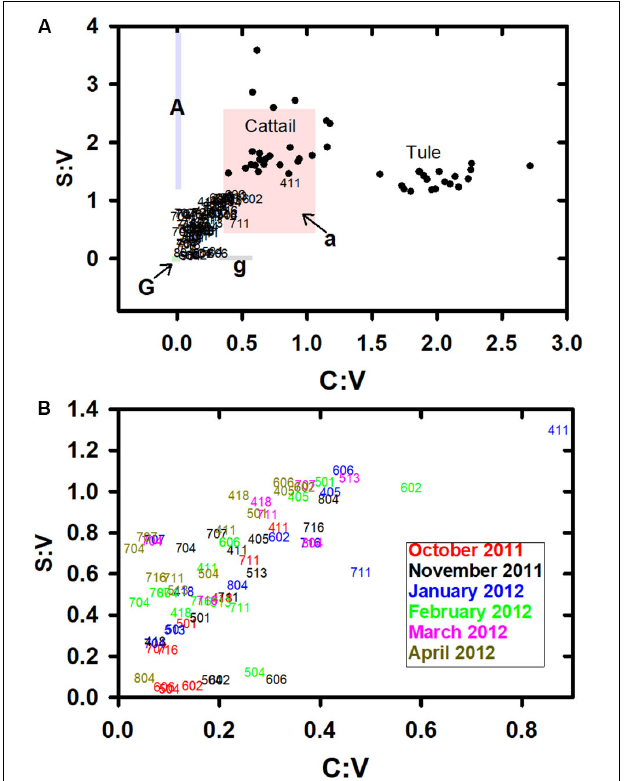
FIGURE 6 | (A) Syringyl to vanillyl ratios, S:V, vs. cinnamyl to vanillyl ratios, C:V, for all samples (identified by station number) in comparison to potential cattail and tule endmembers (unpublished data). Colored regions indicate broad endmember ranges from Hedges and Mann (1979), where G, gymnosperm woody tissues; A, angiosperm woody tissues; g, gymnosperm nonwoody tissues; and a, angiosperm nonwoody tissues. Clearly, these shaded regions are not all-inclusive of all endmembers since analyzed, but they provide important historical context. (B) An expanded view of just the samples in this study, identified by station number with color indicating sampling